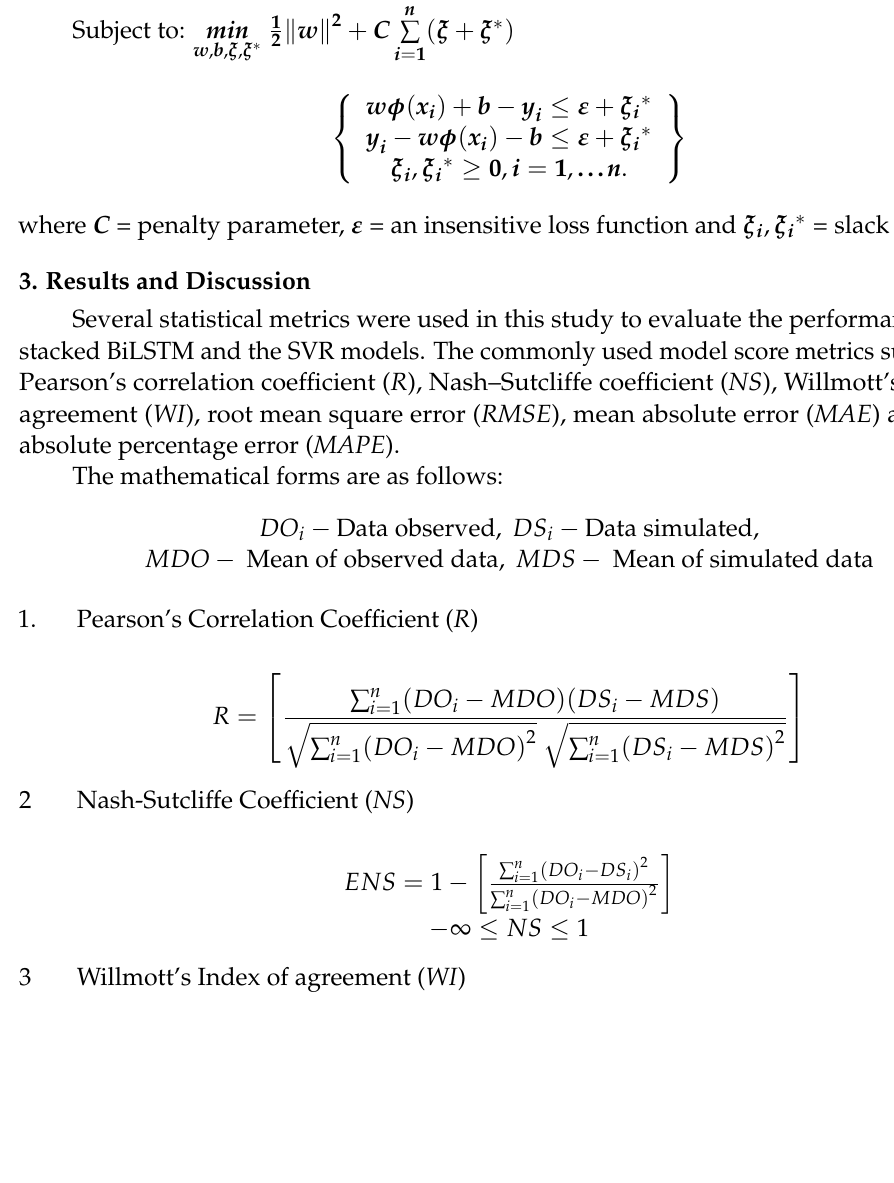
Figure 11. The SVR model structure shows how the error and the hyperplane are arranged around the data points.